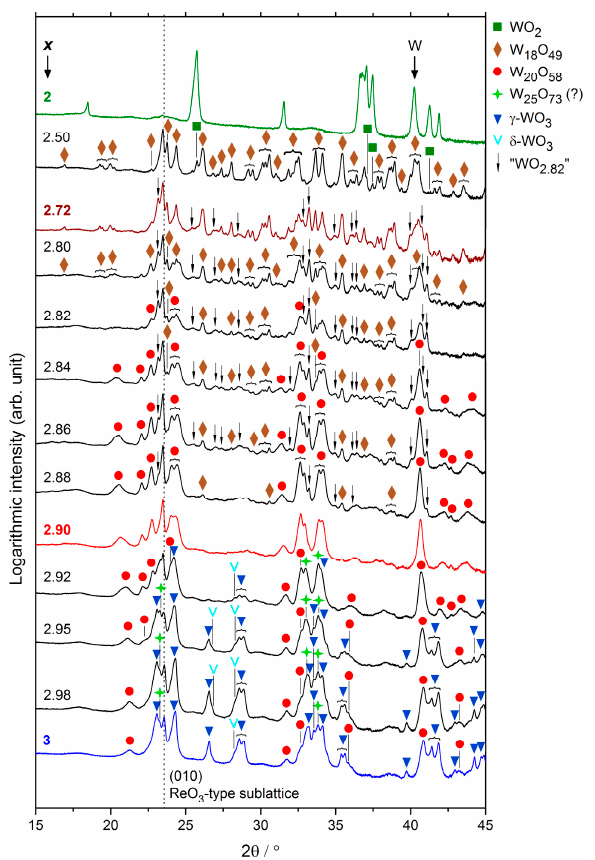
Figure 4. PXRD patterns (Cu-K α 1 radiation) of the WO x samples processed with SPS-1420/10 min. Only the WO 2 reference sample was compacted with SPS-1470 K/10 min (green line).